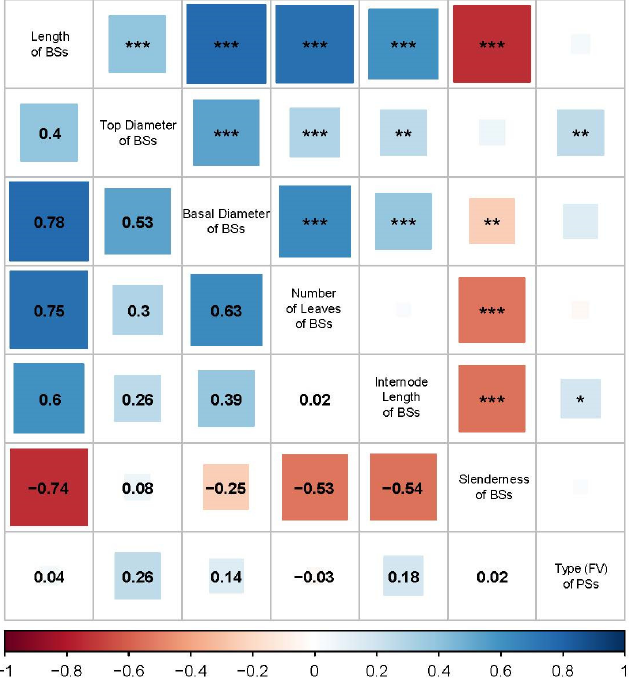
Figure 8. Correlations between each trait for the bearing shoots (BS) and the type of parent shoots for “Yuanhua” Sapindus mukorossi. Note: Length of BS, the length of the BS; Top Diameter of BS, the diameter of the tip of the BS; Basal Diameter of BS, the diameter of the base of the BS; Number of Leaves of BS, the number of leaves of the BS; Internode of Number, the internodal length of the BS; Slenderness of BS, the slenderness of the BS; Type (FV) of PS, the type of parent shoot. * p < 0.05, ** p < 0.01, *** p < 0.001.